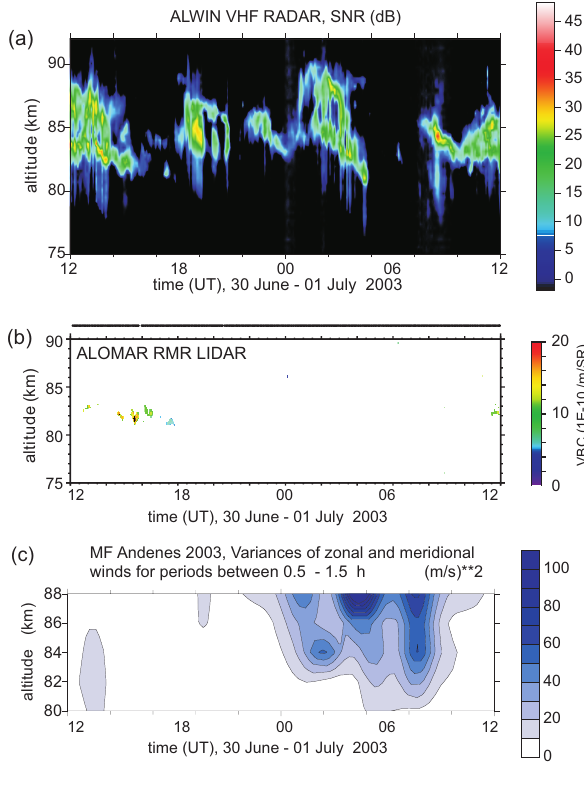
Fig. 12. As Fig. 11, but from 30 June–1 July 2003. The gravity wave activity per mass unit is derived from the MF radar winds using a summarized scale-averaged wavelet power. This method is very efficient (e.g. Hoffmann et al., 2006, 2007) and comparable to the variances estimated after a classical Butterworth band-pass filtering. To improve the resolution, the data have been averaged only over 20 min in the altitude range between 80–88 km instead of the regularly used hourly averaged wind values. The wind variances have been estimated for periods be- tween 0.5–1.5 h and are presented in the lower panels of Figs. 11 and 12. At altitudes of ∼ 84–86 km, periods of en- hanced activity of these waves have been derived on 29 June, ∼ 10:00 UT, and 1 July, 00:00–08:00 UT. Note that during the selected period the SDT shows maximal amplitudes of only 10–12 m/s (Fig. 13), thus indicating a reduced influence of tidal waves in comparison to the case study with enhanced SDT activity from 3–4 August 2000 (Fig. 6, left panel). relatively low occurrence of NLC on 29 June, the absence of NLC on 1 July and only weak PMSE during or after the pe- riods of enhanced activity of short period gravity waves, thus confirming the predictions of the microphysical model simu- lation (Fig. 8). This means that the wave will cause only